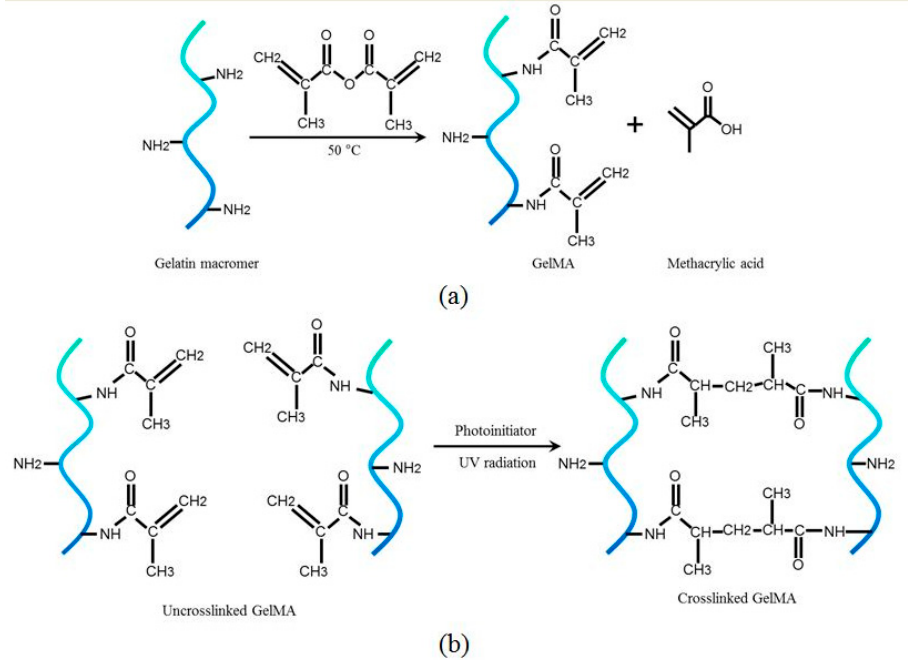
Figure 1. ( a ) Synthesis of gelatin methacrylate (GelMA) through the addition of methacrylamide groups onto the gelatin macromers and ( b ) the crosslinking of GelMA under UV radiation in the presence of a photoinitiator.